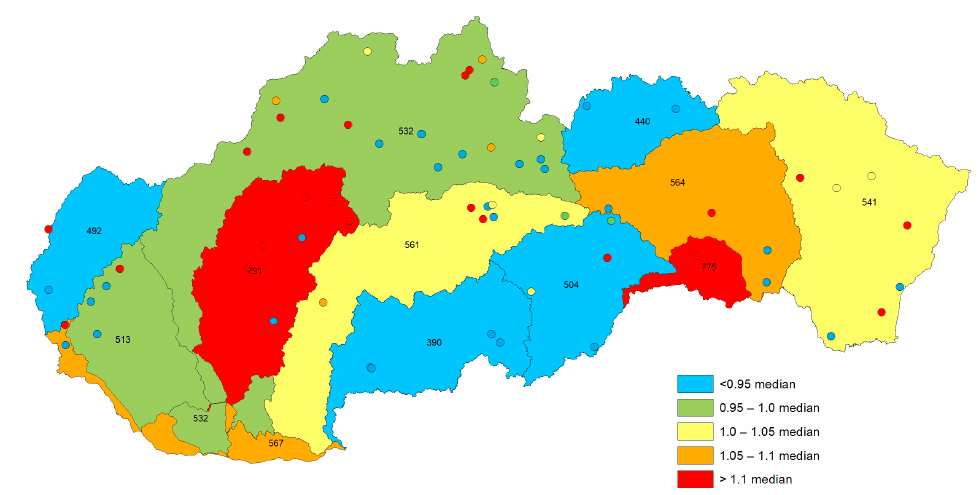
represent the mean number of low-flow days in the individual sub-catchments. the mean number of low-flow days in the individual sub-catchments.